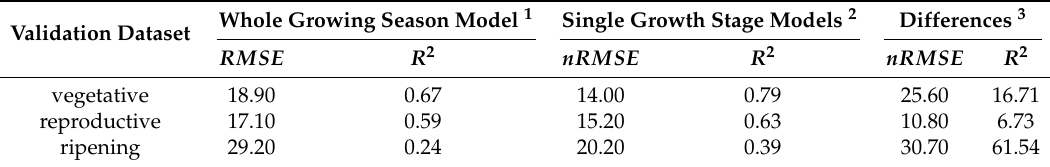
Table 5. The validation nRMSE and R 2 of top-performing vegetation index (VI) models for whole growing season and each separate growth stage. The whole growing season model was validated on each separate growth stage data of the 2017 growing season.